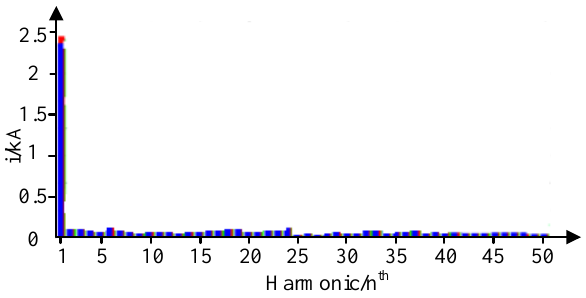
Figure 15. Low-order harmonic analysis of input current of ice-melting rectifier.